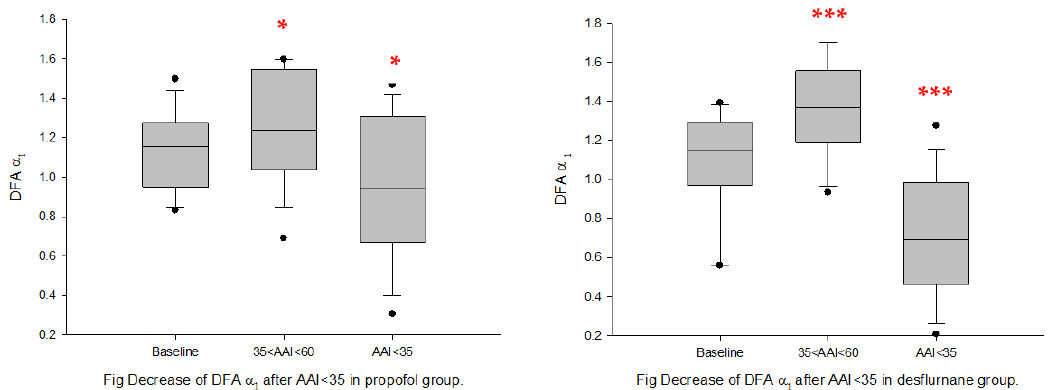
Figure 3. LF/HF ratio at baseline and post-general anesthesia for Group P (propofol); Group D (des- flurane). Box plots show the median, 10th, 25th, 75th, and 90th percentiles as vertical boxes with error bars and plot all data points that lie outside the 10th and 90th percentiles as black circle dots. The significance levels with paired t -tests between baseline and successive measurement periods are as follows: * p < 0.05.